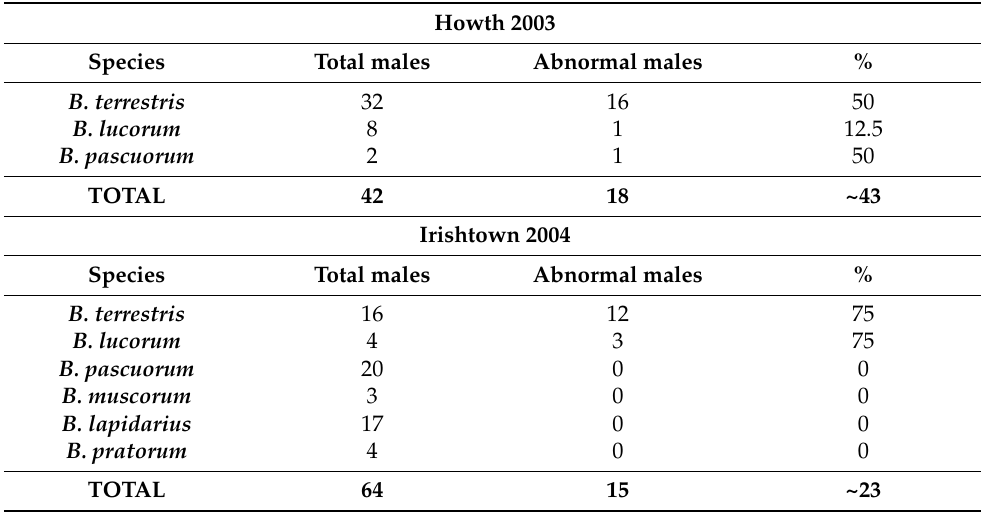
Table 1. Proportion of bumble bee males with an abnormal proventriculus. Total and abnormal males found for each species, and percentage of males with deformed